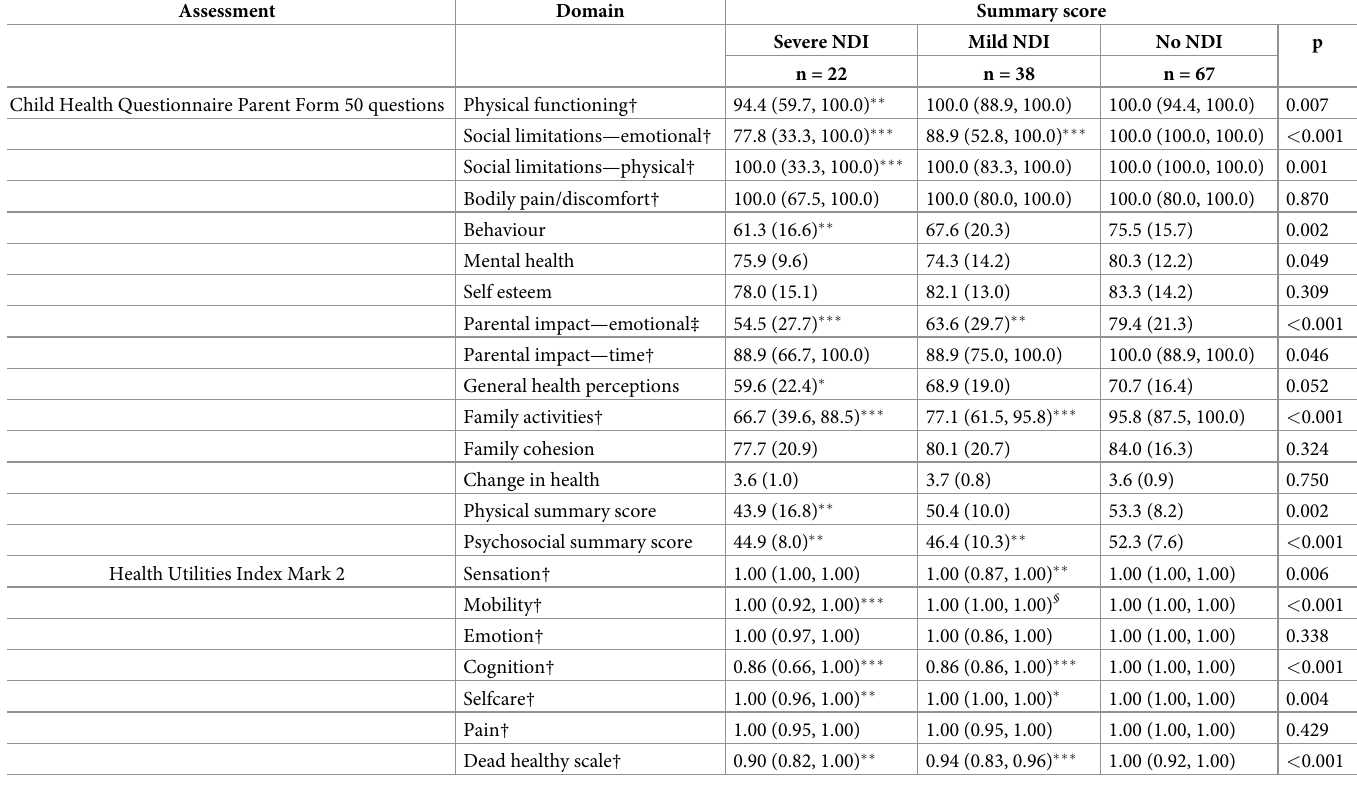
Table 3. Health-related quality of life in children with severe, mild, and no neurodevelopmental impairment.